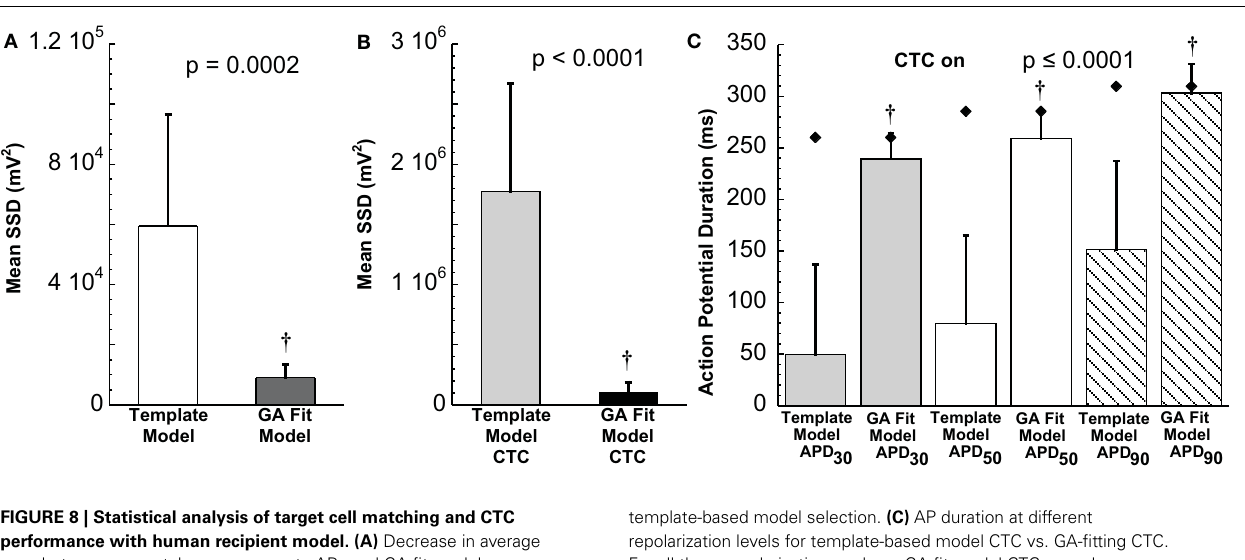
FIGURE 8 | Statistical analysis of target cell matching and CTC performance with human recipient model. (A) Decrease in average error between neonatal mouse myocyte APs and GA-fit models compared to nominal models demonstrating better matching with GA optimization. (B) Average error for CTC-on APs using the human recipient model showing better CTC performance with GA-optimized models over